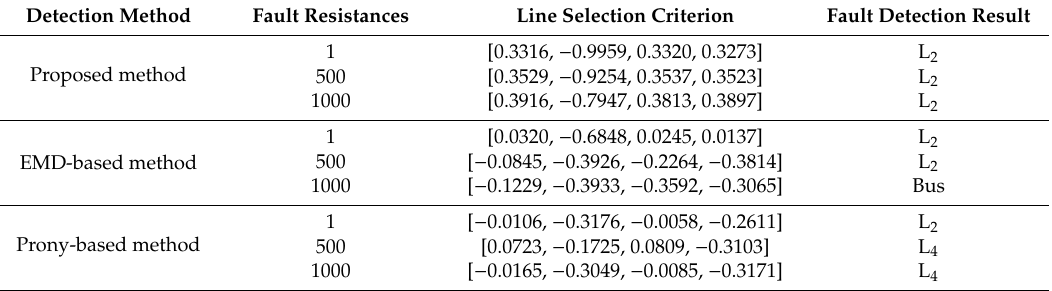
Table 2. Comparisons with the existing fault detection